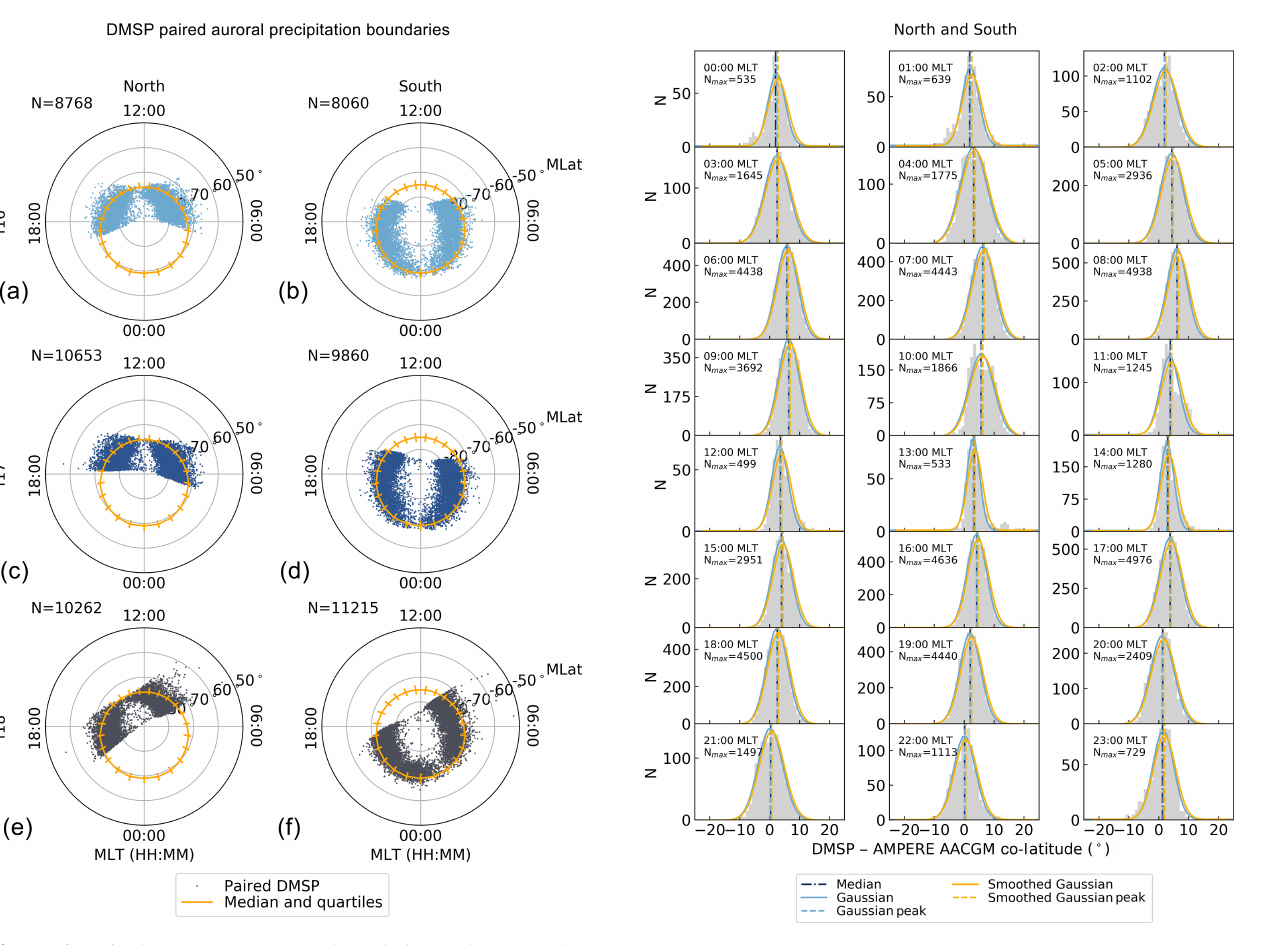
Figure 2. Hourly distributions of paired AMPERE R1–R2 bound- ary and DMSP SSJ OCB latitude differences, with boundary differ- ences from both hemispheres and all satellites. The black dashed line shows the median of the distribution, the blue line shows a Gaussian fit to the distribution and the gold line shows the Gaus- sian fit to the smoothed histogram. The vertical blue and gold lines show the peaks of each Gaussian